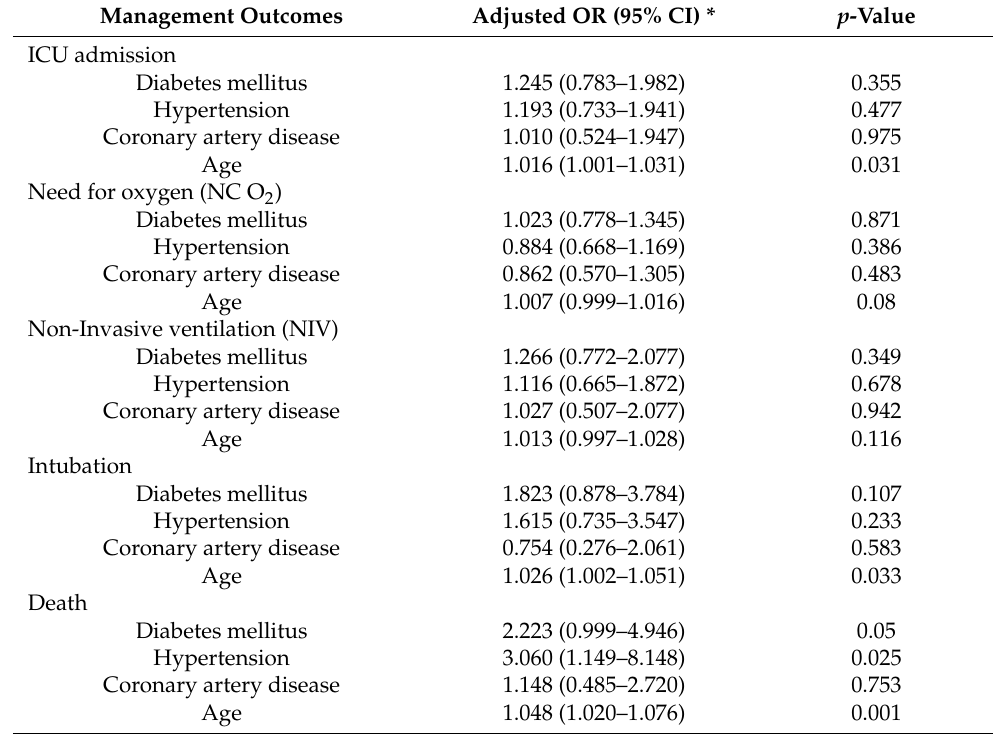
Table 2. Adjusted association between age, hypertension, coronary artery disease, and management. Management